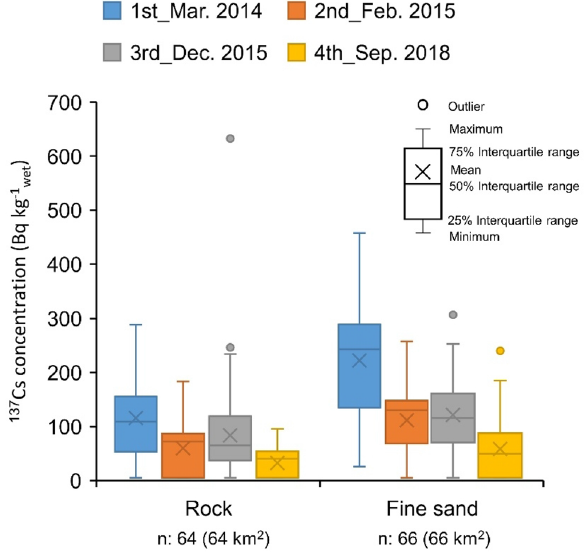
Figure 4. Temporal change of 137 Cs concentration at different geological (rock and fine